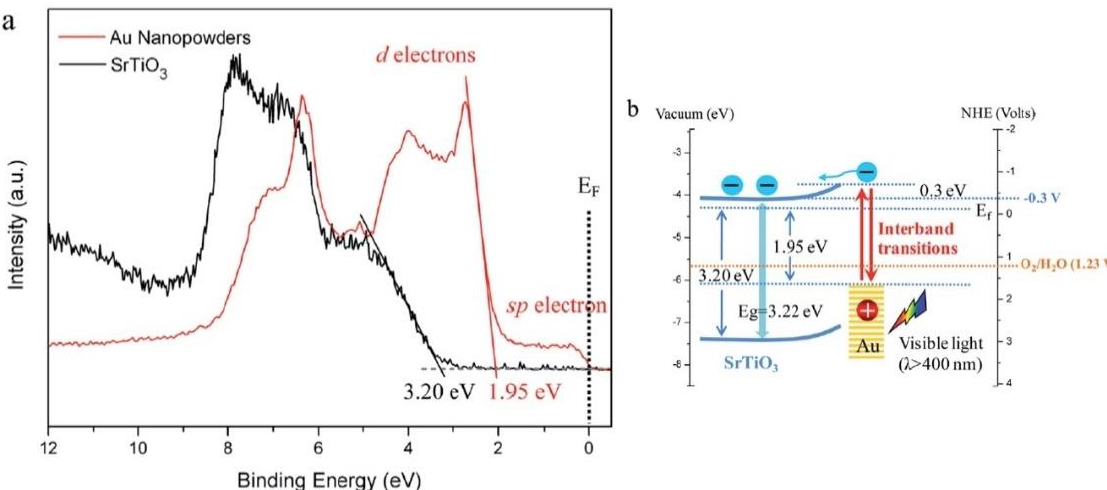
Figure 9. Applying XPS to a gold photosensitized SrTiO 3 system used for visible-light water oxidation via Au interband transitions [158]. ( a ) The use of XPS allows for the measurement of the oxidative potential of holes leaving the plasmonic metal (Au) during interband transitions, and provides a confirmation of the valence band maximum of SrTiO 3 at 3.20 eV below the Fermi level. The band edge of the Au nanopowders can also be identified at 1.95 eV (5d- band edge) with the tail edge attributed to 6sp electrons. This helps in the construction of the band energy diagram of the plasmonic system in ( b ), where the CB minimum of SrTiO 3 is around −0.3 V vs. NHE with the expected band bending after contact (0.3 eV); a basic illustration of the use of XPS methods to illuminate the energy structure of a given surface including measures of the energy distributions and potentials of the charge carriers involved. Reprinted with permission from Ref [158] Copyright Royal Society of Chemistry (2014).